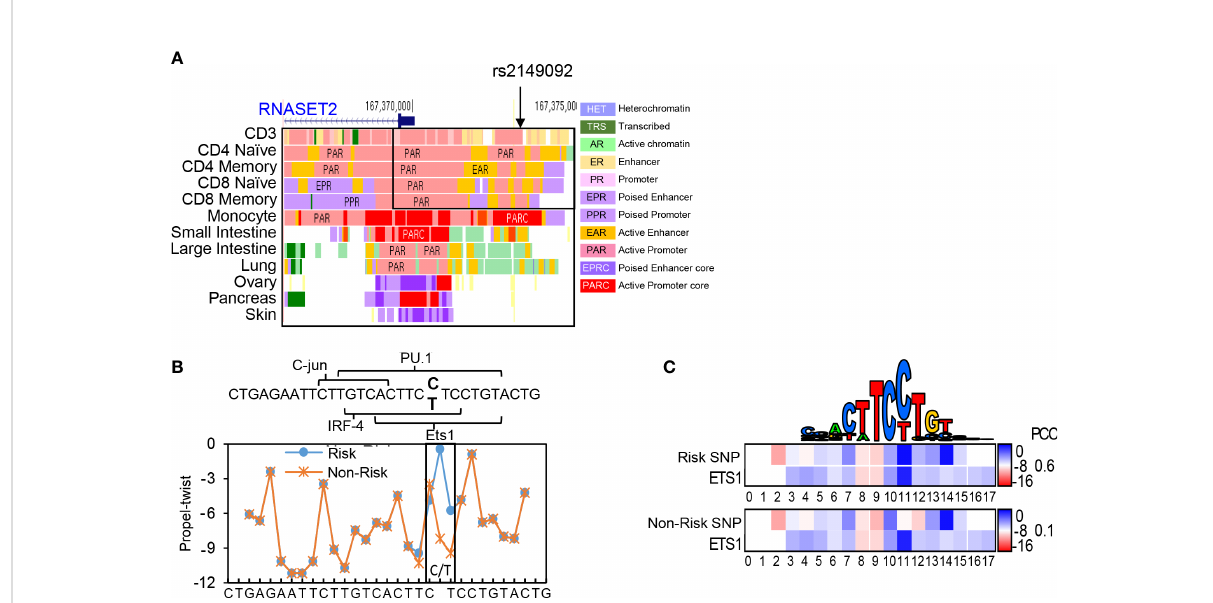
FIGURE 1 Cis-Regulatory SNP, rs2149092, on RNASET2 promoter is predicted to alter ETS TF binding. (A) StateHub modeling of RNASET2 in proximity of SNP rs12149092 (B) DNA topography analysis demonstrating that SNP rs2149092 (C>T) is predicted to alter DNA propeller twist con fi guration at the ETS1 binding site. (C) Heat map and Pearson ’ s correlation coef fi cients (PCC) comparing region containing rs2149092 C and T SNP to consensus ETS1 binding